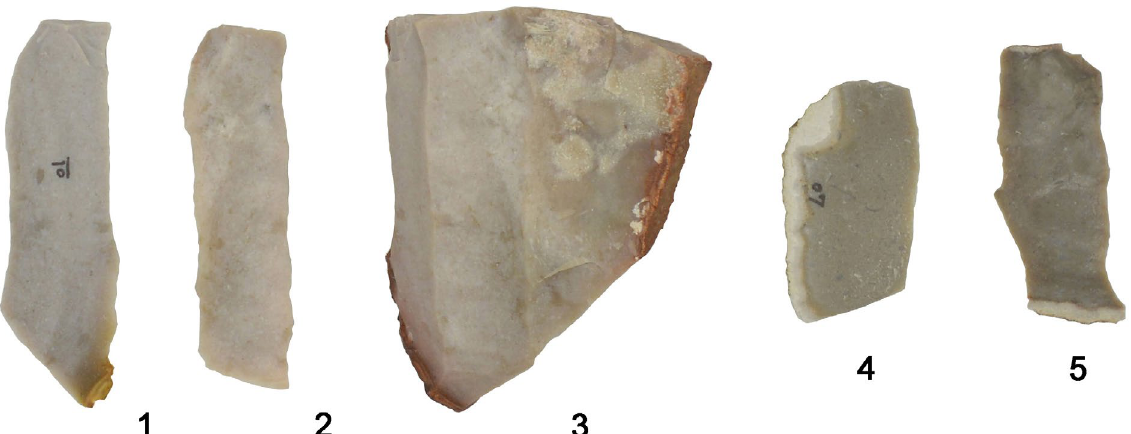
Figure 6. Flint samples successfully heat treated at 350 °C. 1, 4: Blades flaked before heat treatment. 2, 5: Blades flaked after heat treatment. 3: Heat-treated core (1-3: River cobble flint; 4, 5: Nodule flint).